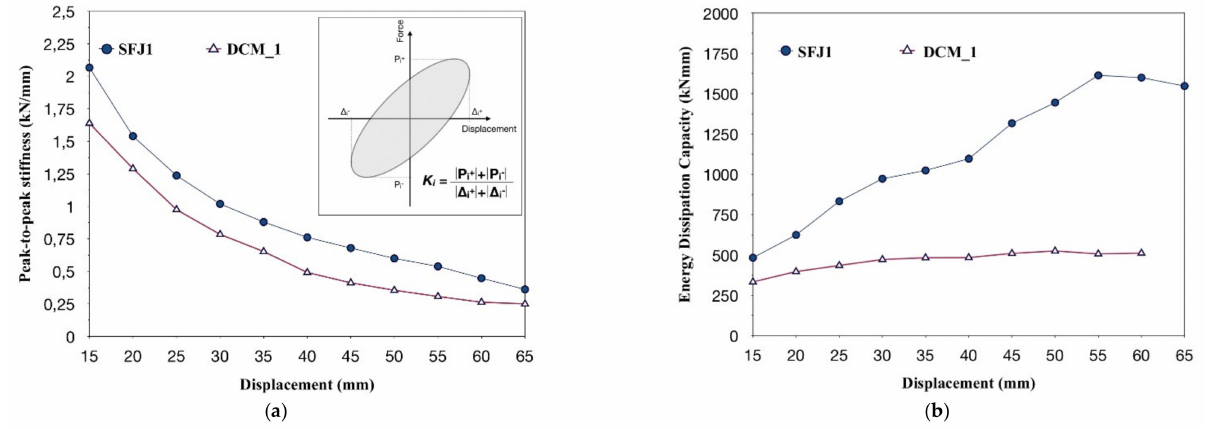
Figure 13. Plots of ( a ) peak-to-peak stiffness versus displacement and ( b ) energy dissipation capacity versus displacement of subassemblages SFJ1 and DCM_1.